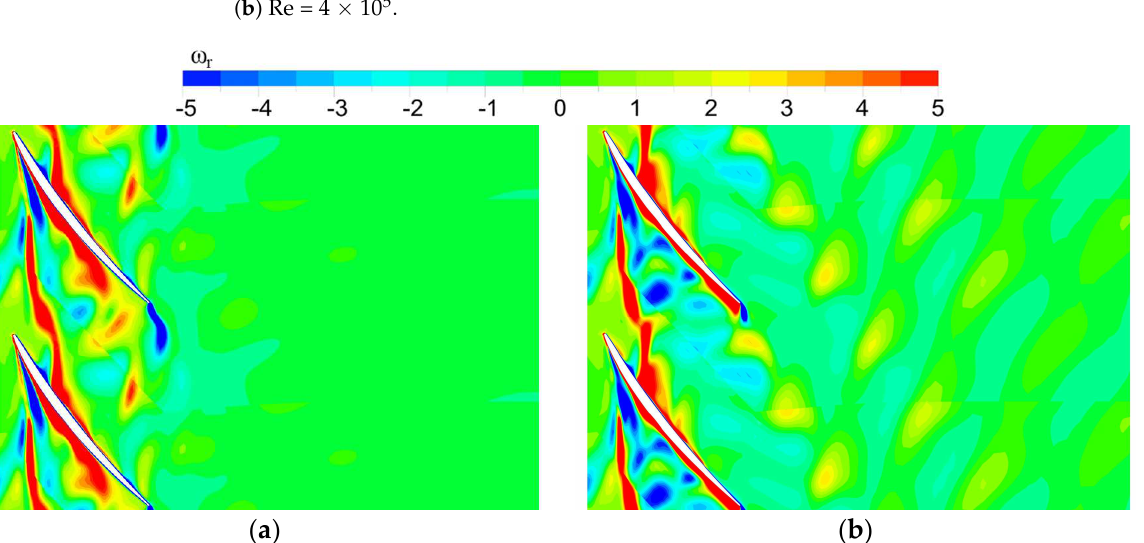
Figure 23. Distribution of transient normalized radial vorticity at 99% span. ( a ) Re = 1 × 10 5 ; ( b ) Re = 4 × 10 5 .